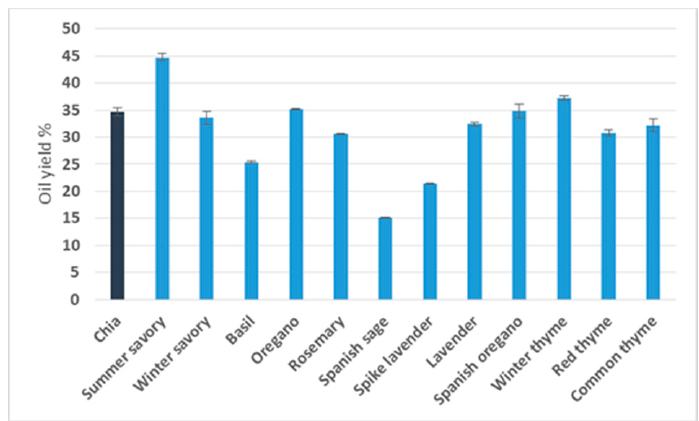
Figure 1. Oil yields (g oil / 100 g dry seeds) from the Lamiaceae seeds under study.